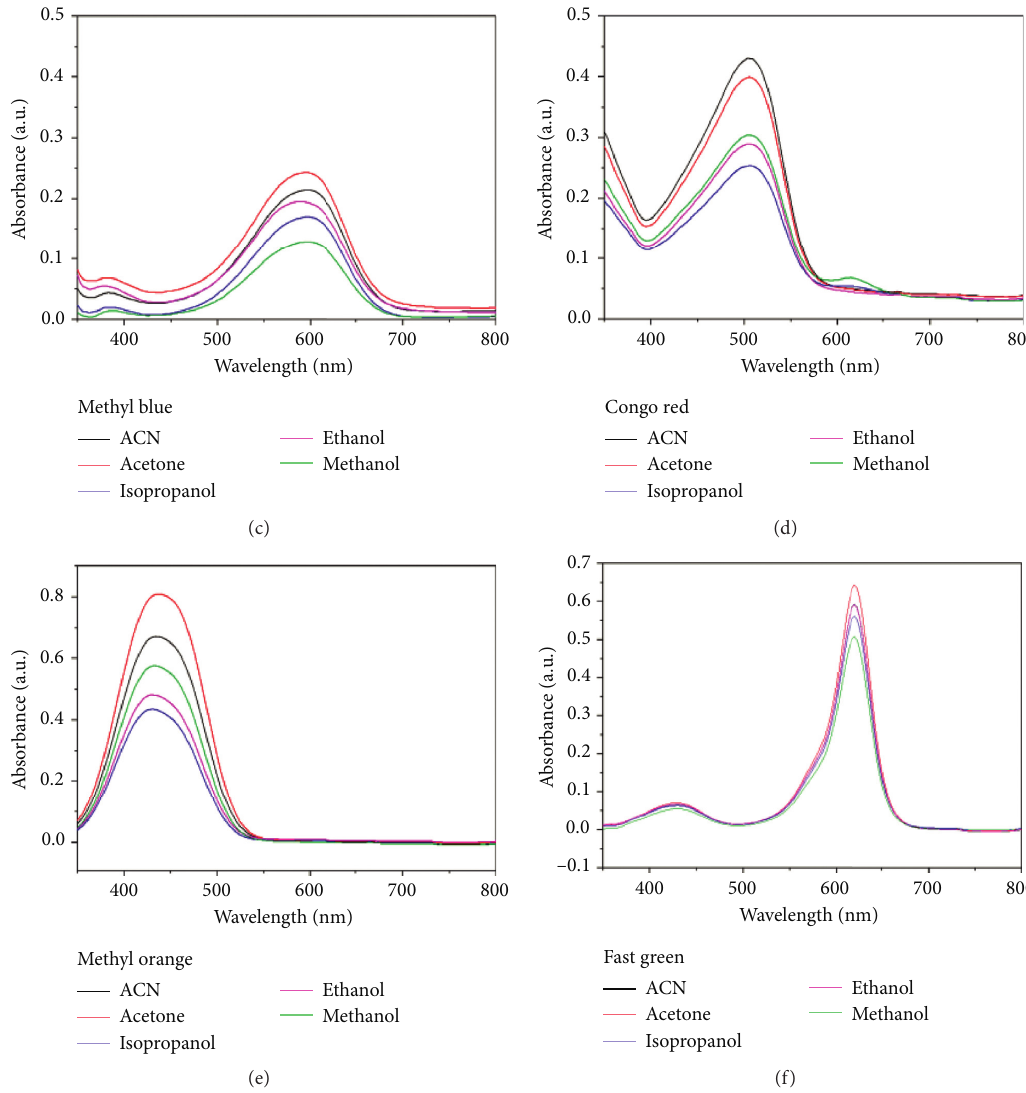
Figure 9: UV-Vis spectra of the preconcentrated dyes using different desorption solvents (acetone, acetonitrile, isopropanol, ethanol, or